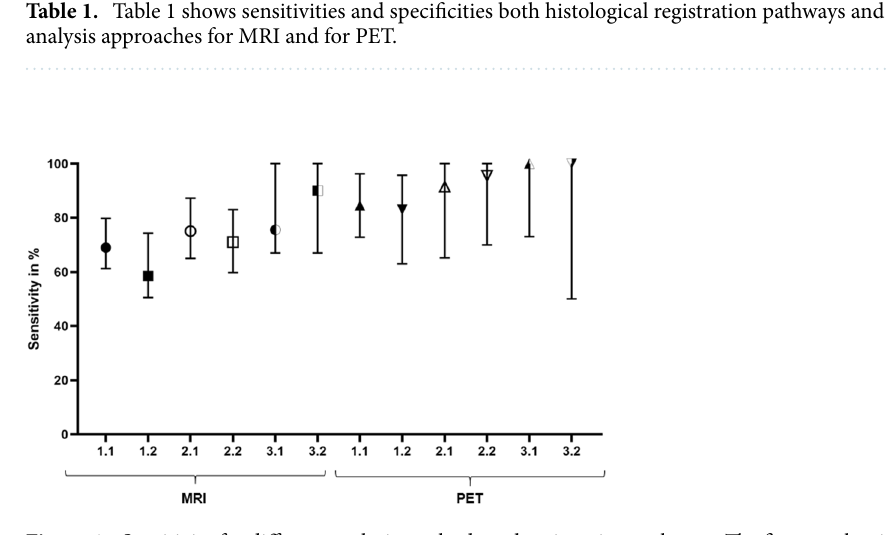
Figure 4. Sensitivity for different analysis methods and registration pathways. The first number indicates the used analysis method (1 = slice-by-slice quadrant based, 2 = 18 segments, 3 = 6 segments) and the second number indicates the used intermediate co-registration pathway: 1 = via ex-vivo CT followed by co-registration of ex-vivo CT and in-vivo CT, 2 = via ex-vivo MRI followed by co-registration of ex-vivo MRI and in-vivo MRI. The median values and interquartile ranges over all patients are